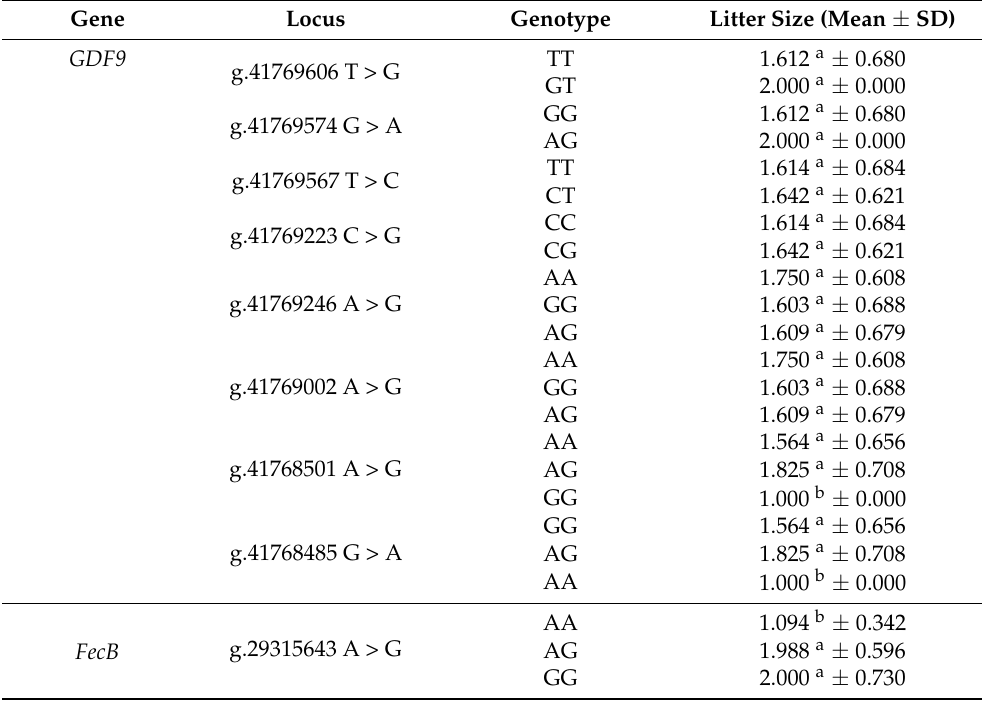
Table 4. Least-square means and standard errors of litter size for different genotypes of nine loci in